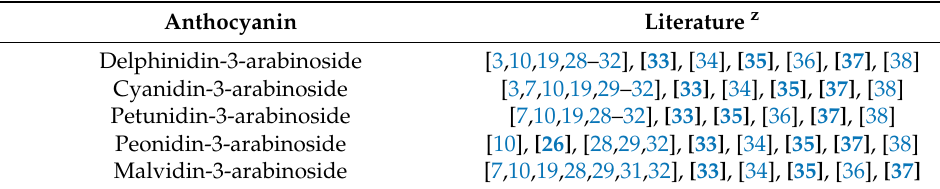
Table 2. Anthocyanins in blueberries from the